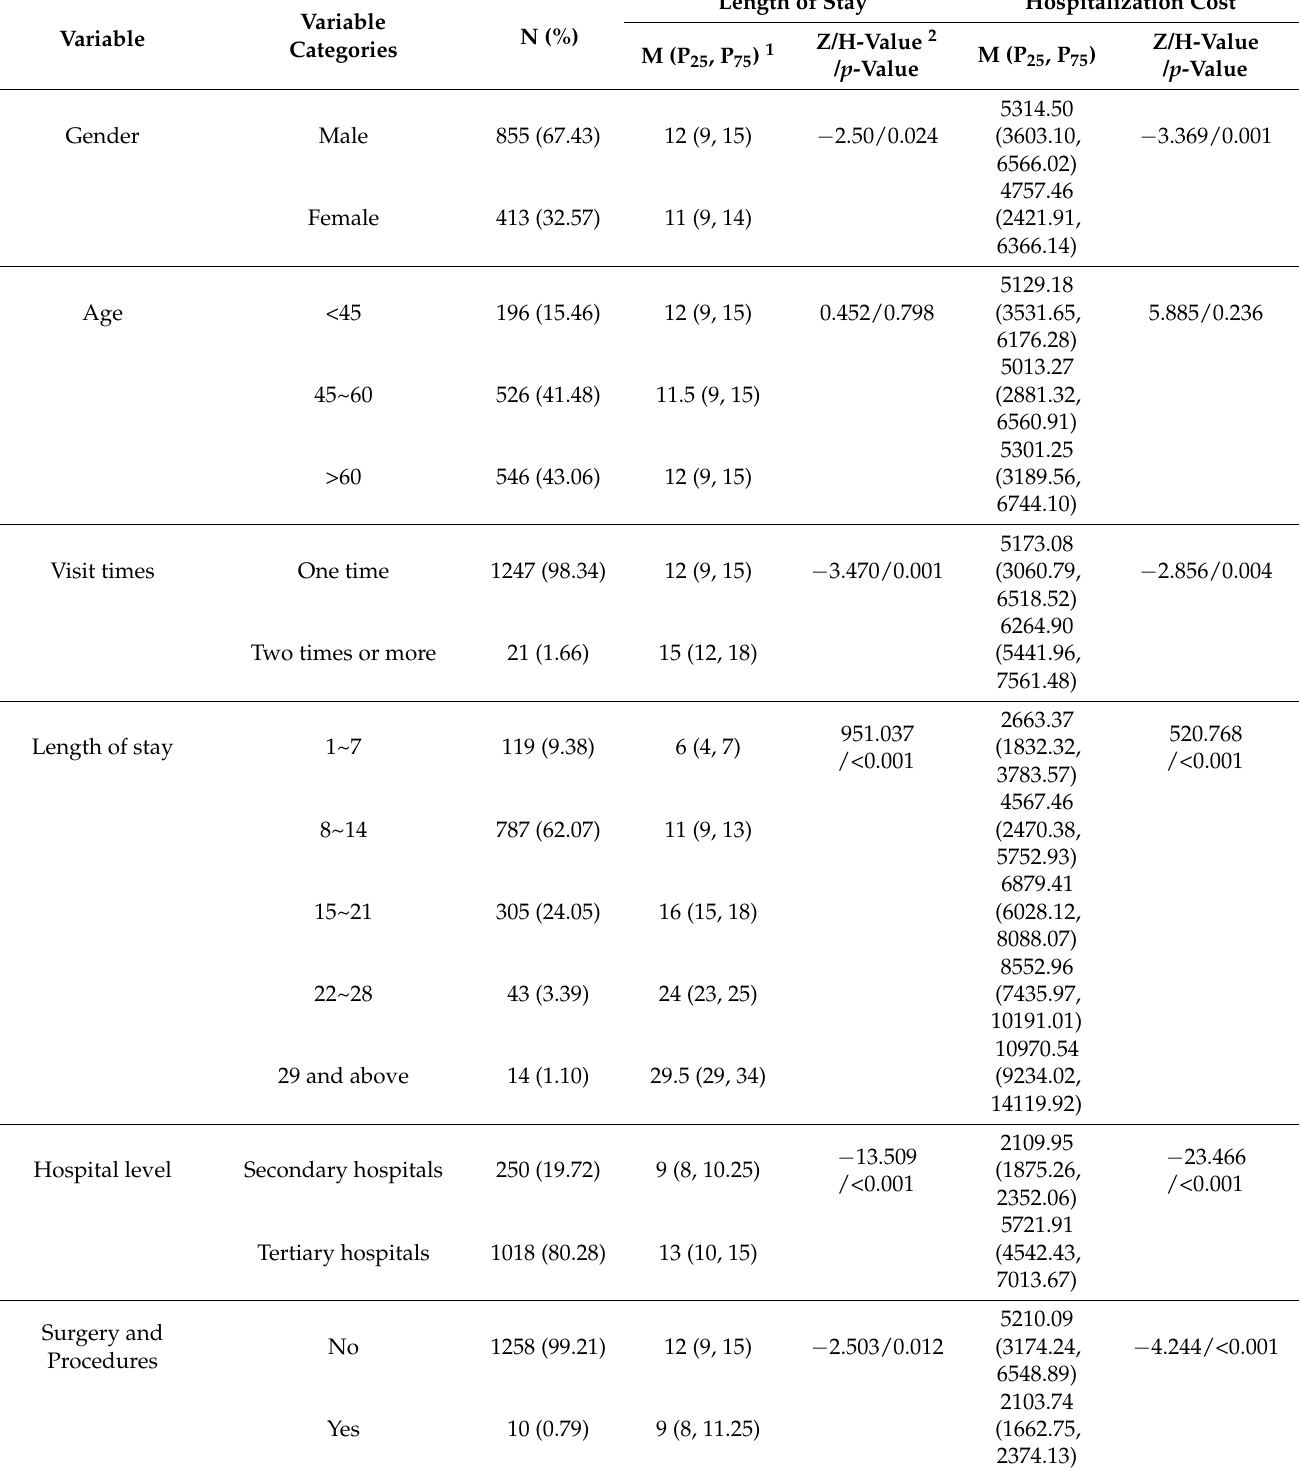
Table 2. Univariate analysis results of the length of stay and hospitalization cost for diabetic